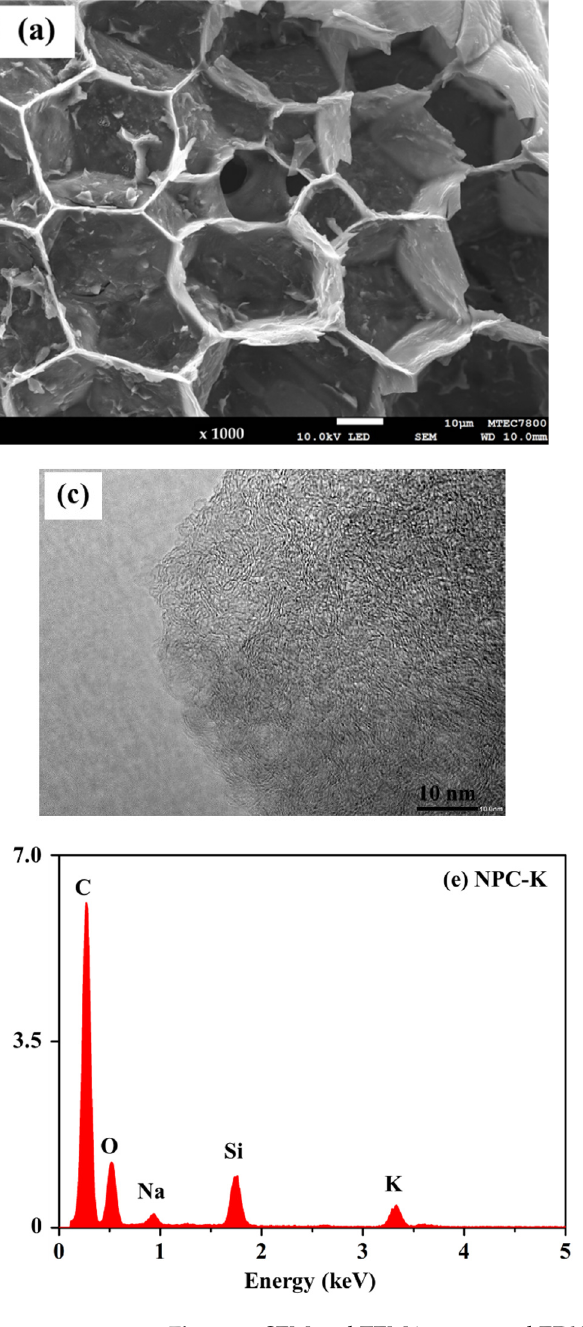
Figure 1. SEM and TEM images, and EDX spectra of ( a , c , e ) NPC-K and ( b , d , f ) NPC-H.